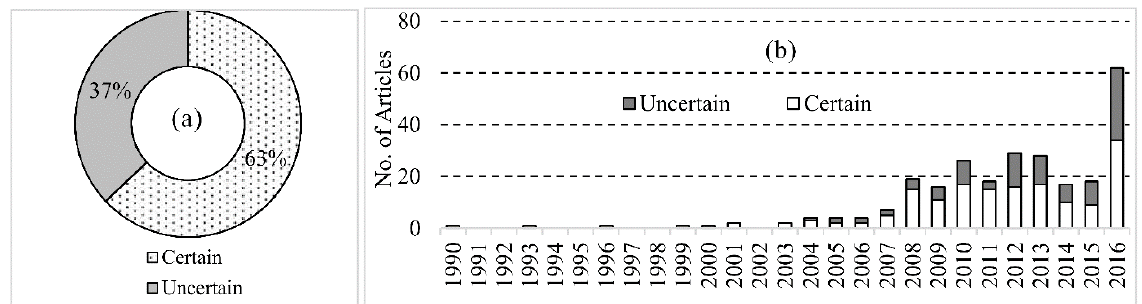
Figure 7. Contribution of certain and uncertain models in the reviewed articles and their frequencies over